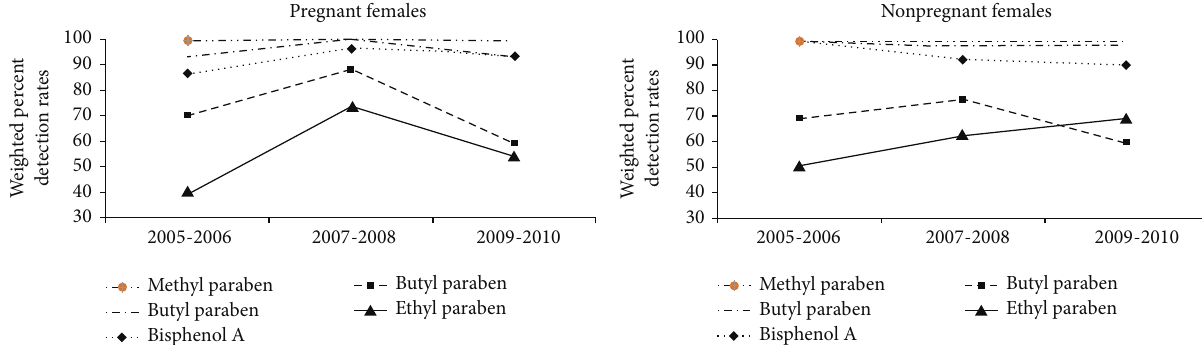
Figure 1: Weighted percent detection rates for bisphenol A and butyl, ethyl, methyl, and propyl parabens for pregnant and nonpregnant females.